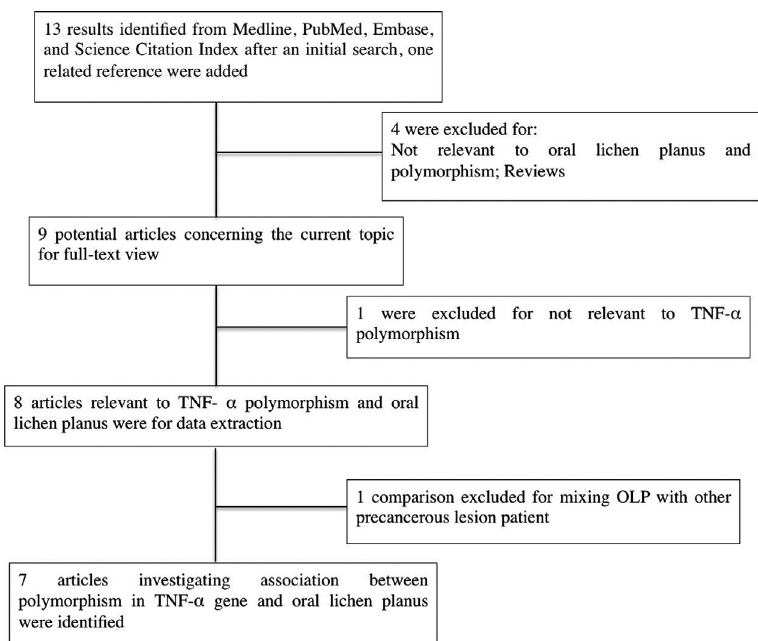
Figure 1- Flow chart for the process of selecting associated